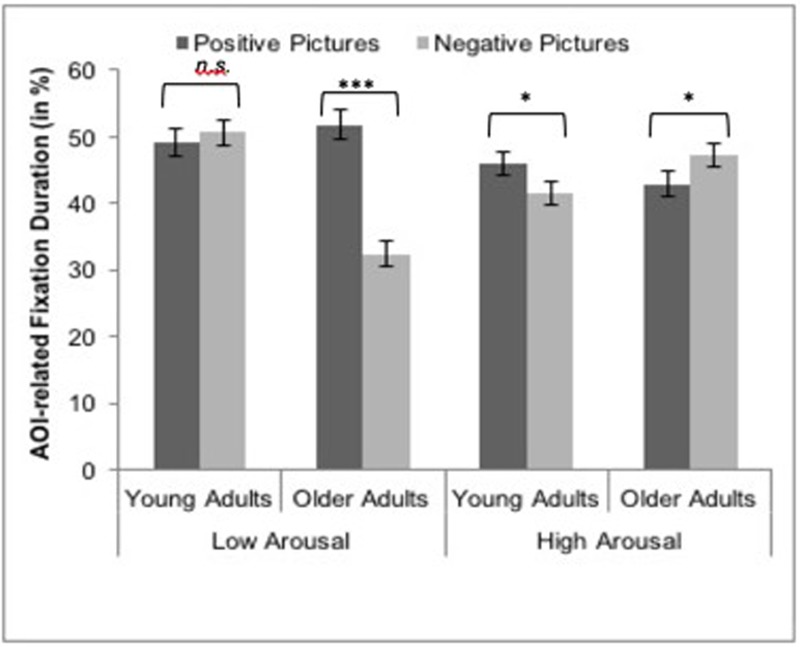
Means (± standard errors) of young (N = 21) and older (N = 19) adults’ AOI-related fixation duration (i.e., percentage of fixation duration on AOIs relative to the rest of the picture) for low- and high-arousing positive and negative pictures. ∗p < 0.05, ∗∗∗p < 0.001.